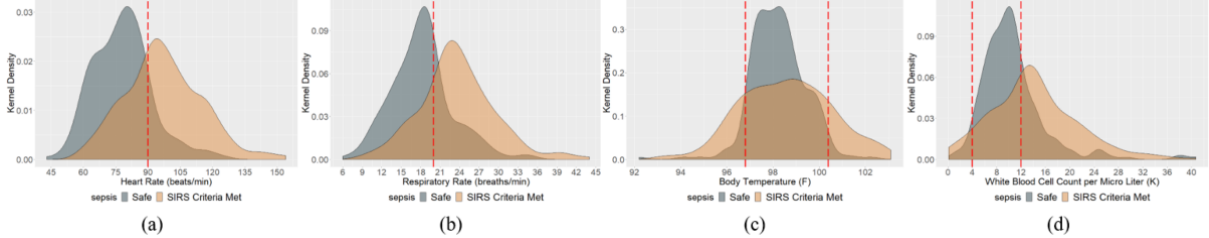
Figure 5. Kernel density estimation distribution of systemic inflammatory response syndrome (SIRS) parameters for both safe and sepsis criterion–met observations to identify the prevalent SIRS